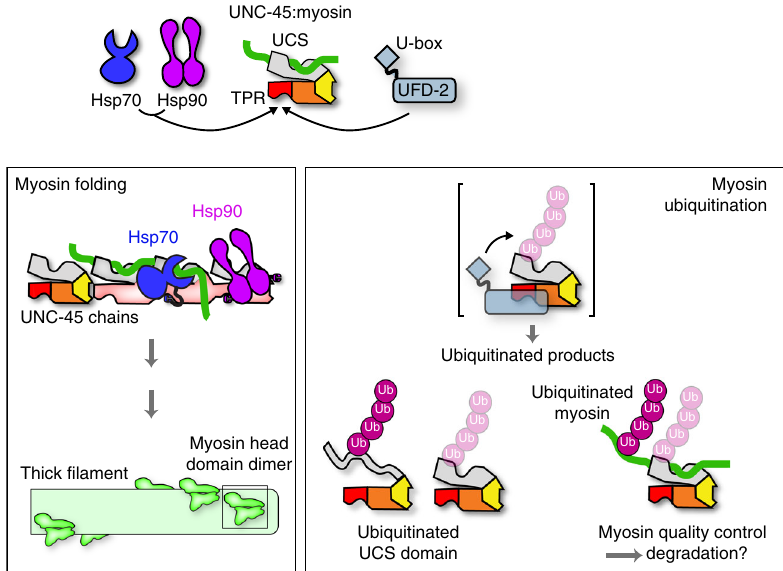
Fig. 8 Collaboration of UFD-2 and UNC-45 with quality-control muscle myosin. UNC-45 is a myosin chaperone that teams up with Hsp70/Hsp90 to promote the folding and assembly of muscle myosin (left). Our data show that the UFD-2 ubiquitin ligase is another partner protein of UNC-45, re- directing the chaperone toward a ubiquitination pathway. Upon binding to its TPR domain (red), the UFD-2 E3 ligase gets properly positioned to poly- ubiquitinate a presented protein, either the UCS domain (gray) of UNC-45 itself or a UCS-bound myosin (green). Importantly, UFD-2 has a clear preference for marking unfolded proteins, as